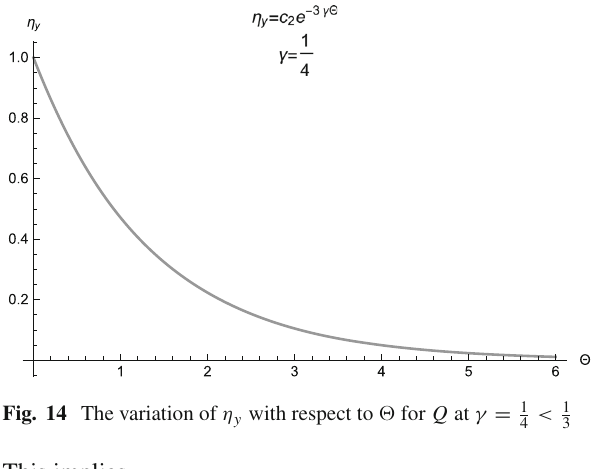
Fig. 14 The variation of η y with respect to (cid:16) for Q at γ = 1